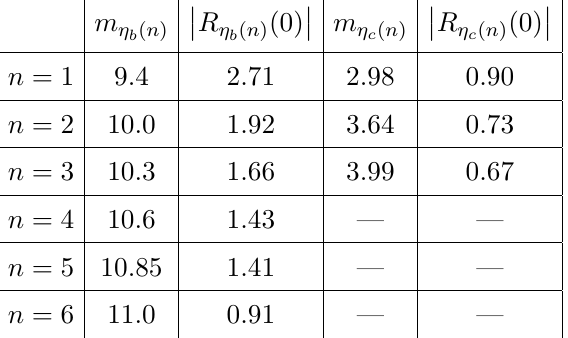
Table 2 . Masses of the (cid:17) b ( n ) and (cid:17) c ( n ) bound states in units of GeV and the corresponding values of the radial wave functions in units of GeV 3 = 2